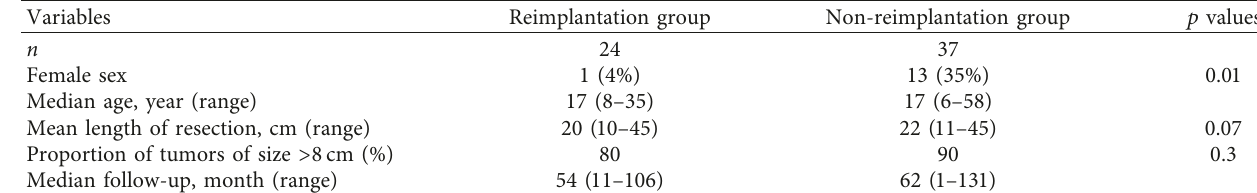
Table 1: Baseline characteristics of reimplantation and the non-reimplantation